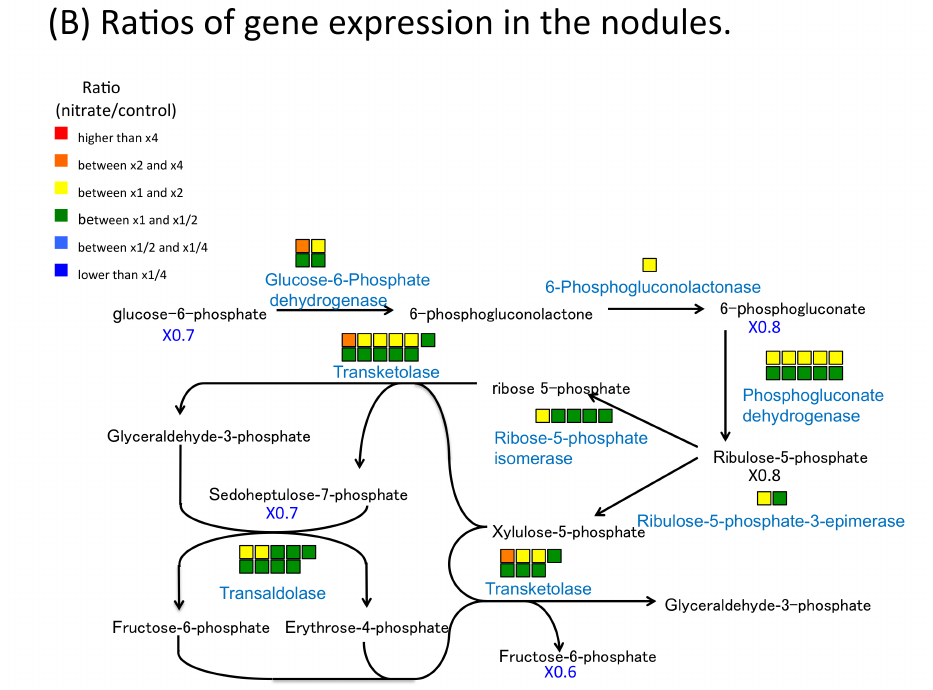
Figure 7. Ratios of gene expression and metabolite concentration related to the pentose phosphate pathway in soybean roots or nodules after 24 h of the 5-mM nitrate treatment. ( A ) Ratios of gene expression and metabolite concentration in the roots. ( B ) Ratios of gene expression and metabolite concentration in the nodules. The model shows the metabolic map of glycolysis in the root or nodule cells. The color of squares above enzyme name and the number under the compound abbreviation indicate the same as Figure